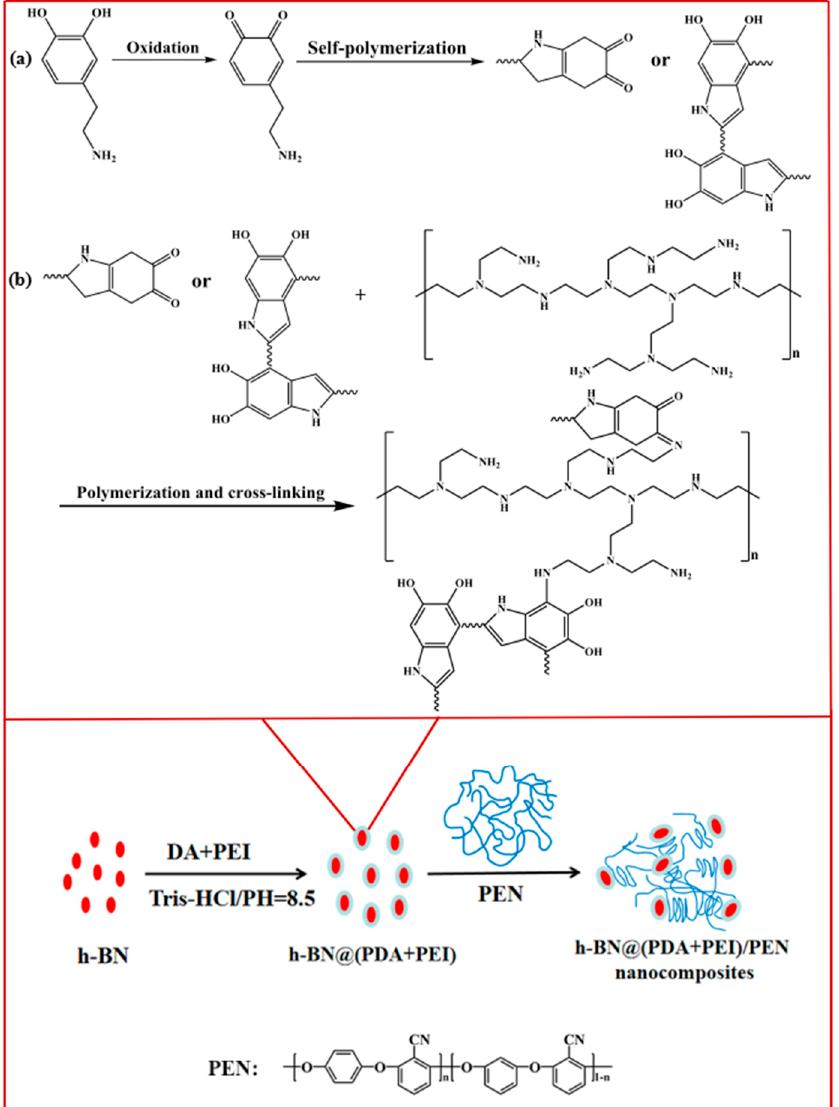
Figure 1. Preparation process of functionalized h-BN / PEN nanocomposite films and possible chemical reaction between PDA and PEI.